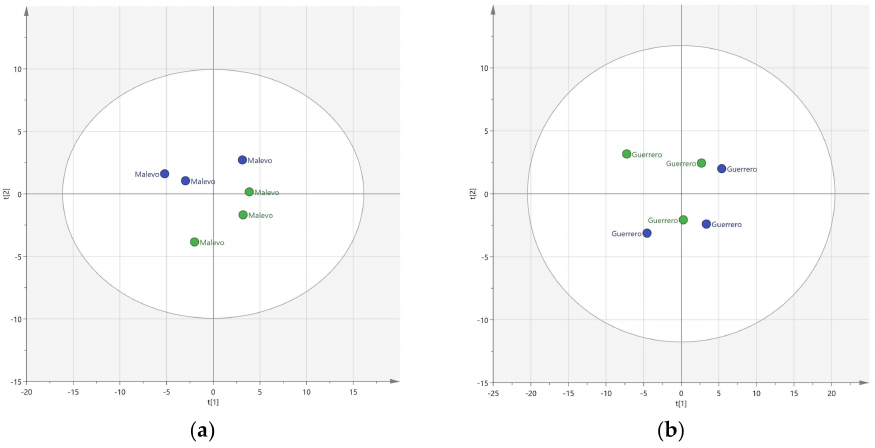
Figure 2. Principal component analysis: PC 1 vs. PC 2 of ( a ) Malevo; and ( b ) Guerrero. With N—blue; without N—green.